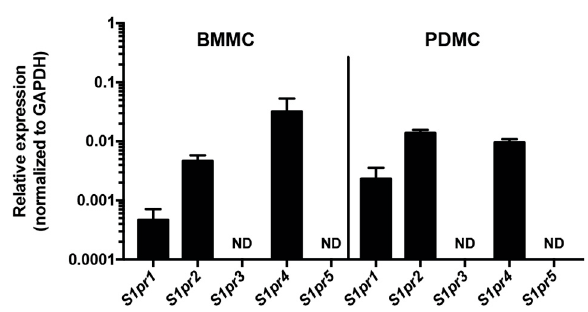
Figure 1. S1P 4 is expressed in mast cells. Quantitative PCR data showing the relative expression of S1P receptor message normalized to glyceraldehyde 3-dehydrogenase (GAPDH) in bone marrow-derived mast cells (BMMC, left ) and peritoneal-derived mast cells (PDMC, right ). Plots represent the mean ± SE (or SD for PDMC) of data pooled from 7 independent BMMC or 2 PDMC cultures. ND: Not detected.